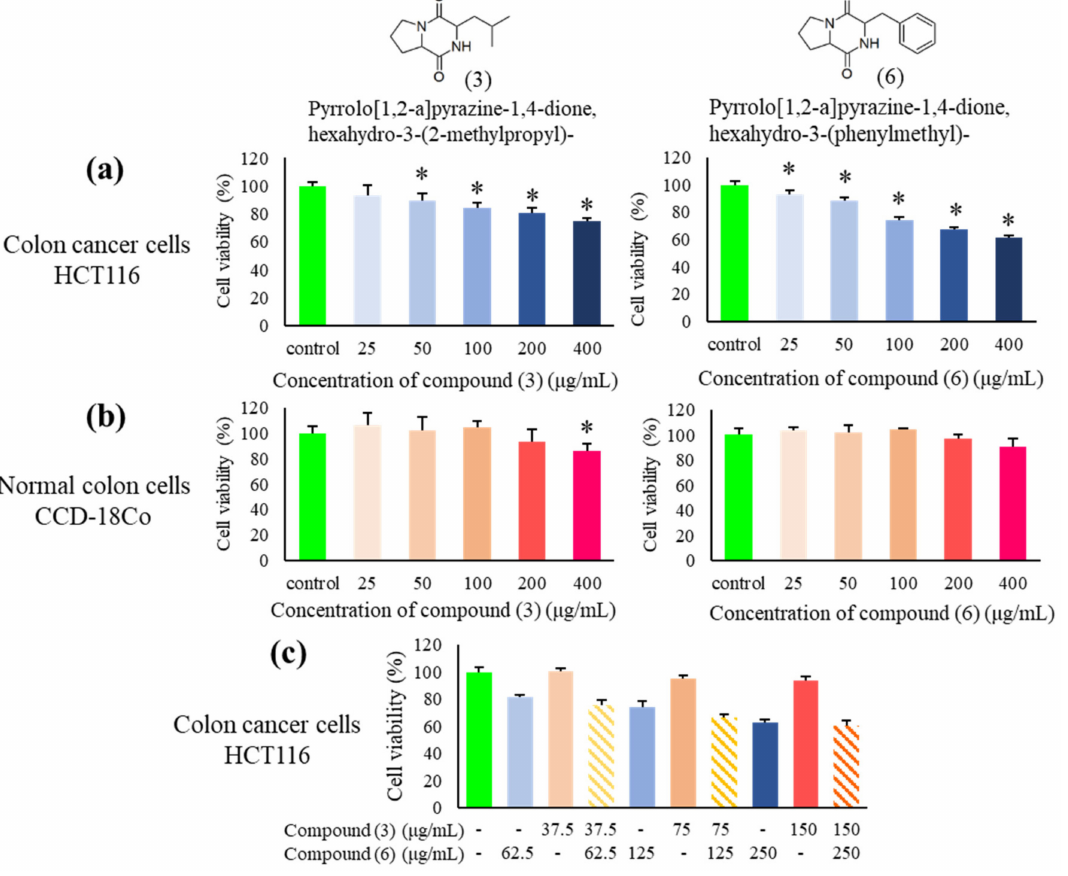
Figure 10. Cytotoxic effects of the two main Compounds (3) and (6) on HCT116 and CCD-18Co cells. ( a ) Cytotoxic effect of pyrrolo [1,2-a] pyrazine-1,4-dione, hexahydro-3-(2-methylpropyl)- ( 3 ) and pyrrolo [1,2-a] pyrazine-1,4-dione, hexahydro-3-(phenylmethyl)- ( 6 ) against HCT116 cells at a series of concentrations after 72 h treatment, ( n = 5, * p < 0.05). ( b ) The toxicity of pyrrolo [1,2-a] pyrazine-1,4-dione, hexahydro-3-(2-methylpropyl)- ( 3 ) and pyrrolo [1,2-a]pyrazine-1,4-dione, hexahydro-3-(phenylmethyl)- ( 6 ) towards CCD-18Co after 72 h exposure, ( n = 5, * p < 0.05). ( c ) The combined effect of Compounds ( 3 ) and ( 6 ) on HCT116 at respective concentrations after 72 h treatment, ( n = 5, * p <